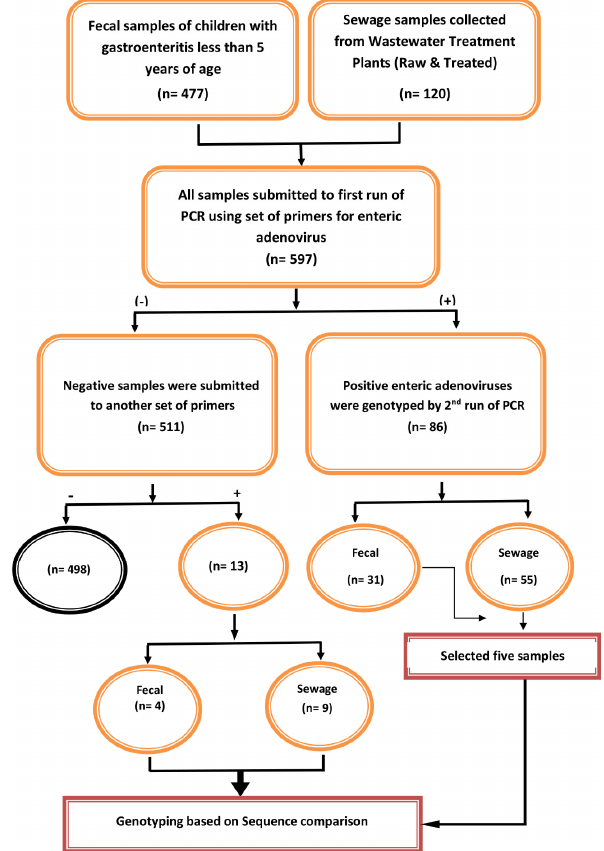
Figure 1. Simplified flow chart describing the number and type of collected samples and their fur- ther processing (typing and genotyping) during this study.